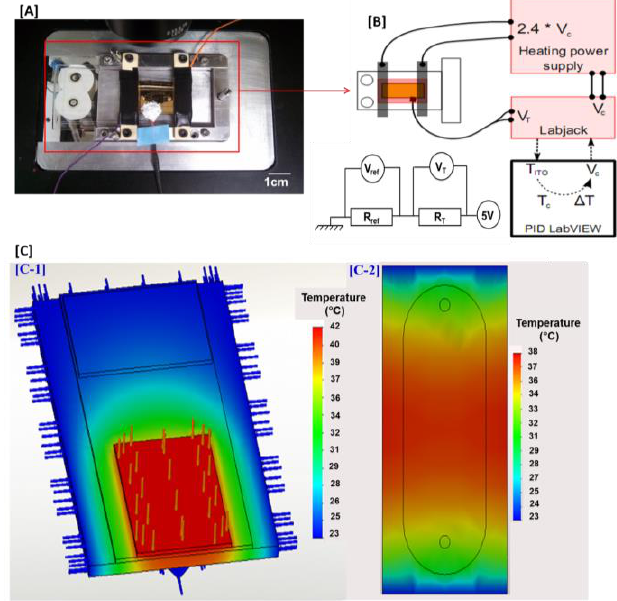
Figure 4. The thermal regulation device. ( A ) Picture of the experimental setup of the biochip and the PDMS microfluidic assembly mounted on a homemade Leica DMI4000 B microscope plate and connected to the thermal regulation device; ( B ) scheme of the thermal measurement and regulation system; and ( C ) stationary temperature field simulation performed on SolidWorks. The ITO-coated glass slide is heated-up at 42 °C to obtain a temperature of 37 °C in the microfluidic chamber. (C-1) Global view of the device; Temperature scale: 23 °C to 42 °C. (C-2) Field temperature on the biochip surface; Temperature scale: 23 °C to 38